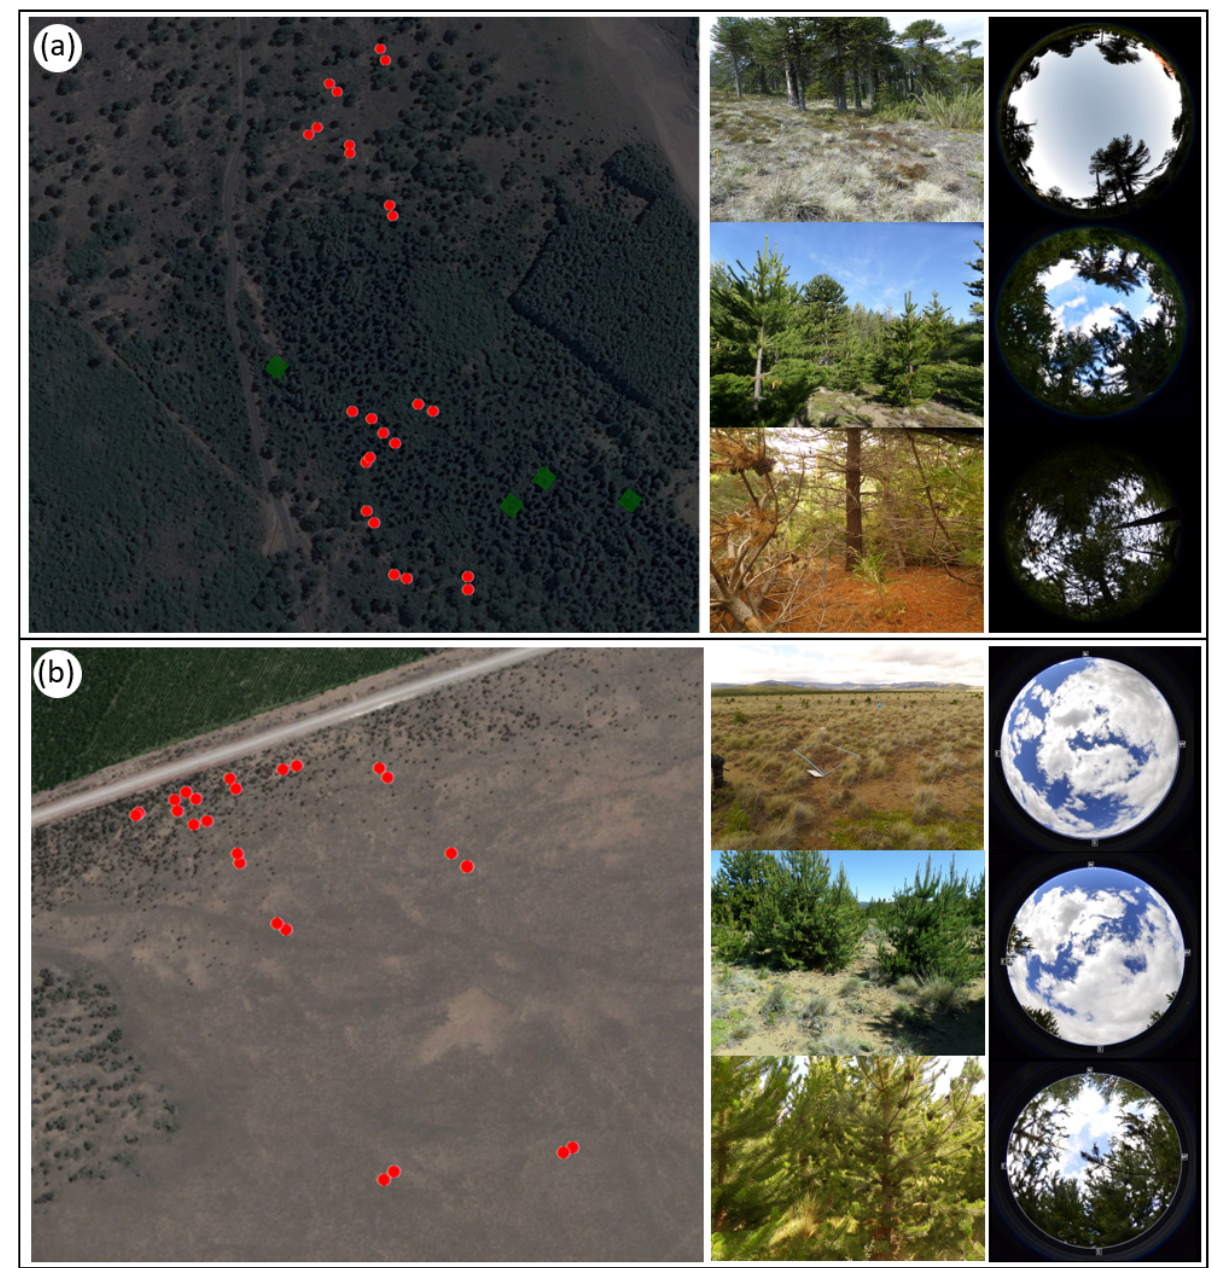
Figure 2. Aerial photograph of the study sites with 10 × 10 m plots along an invasion gradient (red dots) and general characterization associated with hemispheric photos of the level of invasion (low, medium, and high) of P. contorta for A. araucana forests ( a ) and the Patagonian steppe ( b ). Dark green polygons show initial establishment of P. contorta plantations.